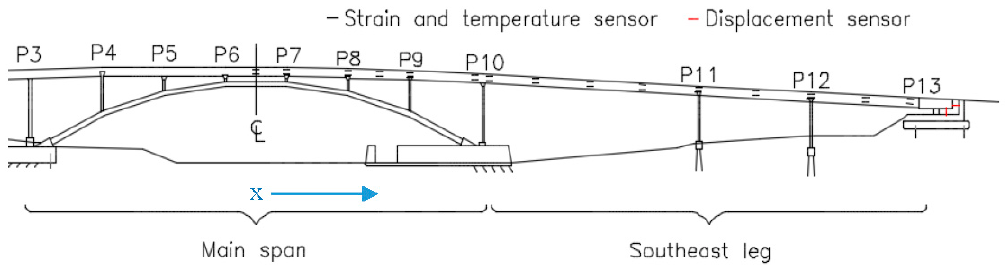
Figure 1. Example of a beam-like bridge instrumented with a chain of parallel sensors along the deck and displacement sensors at extremity (Streicker Bridge).